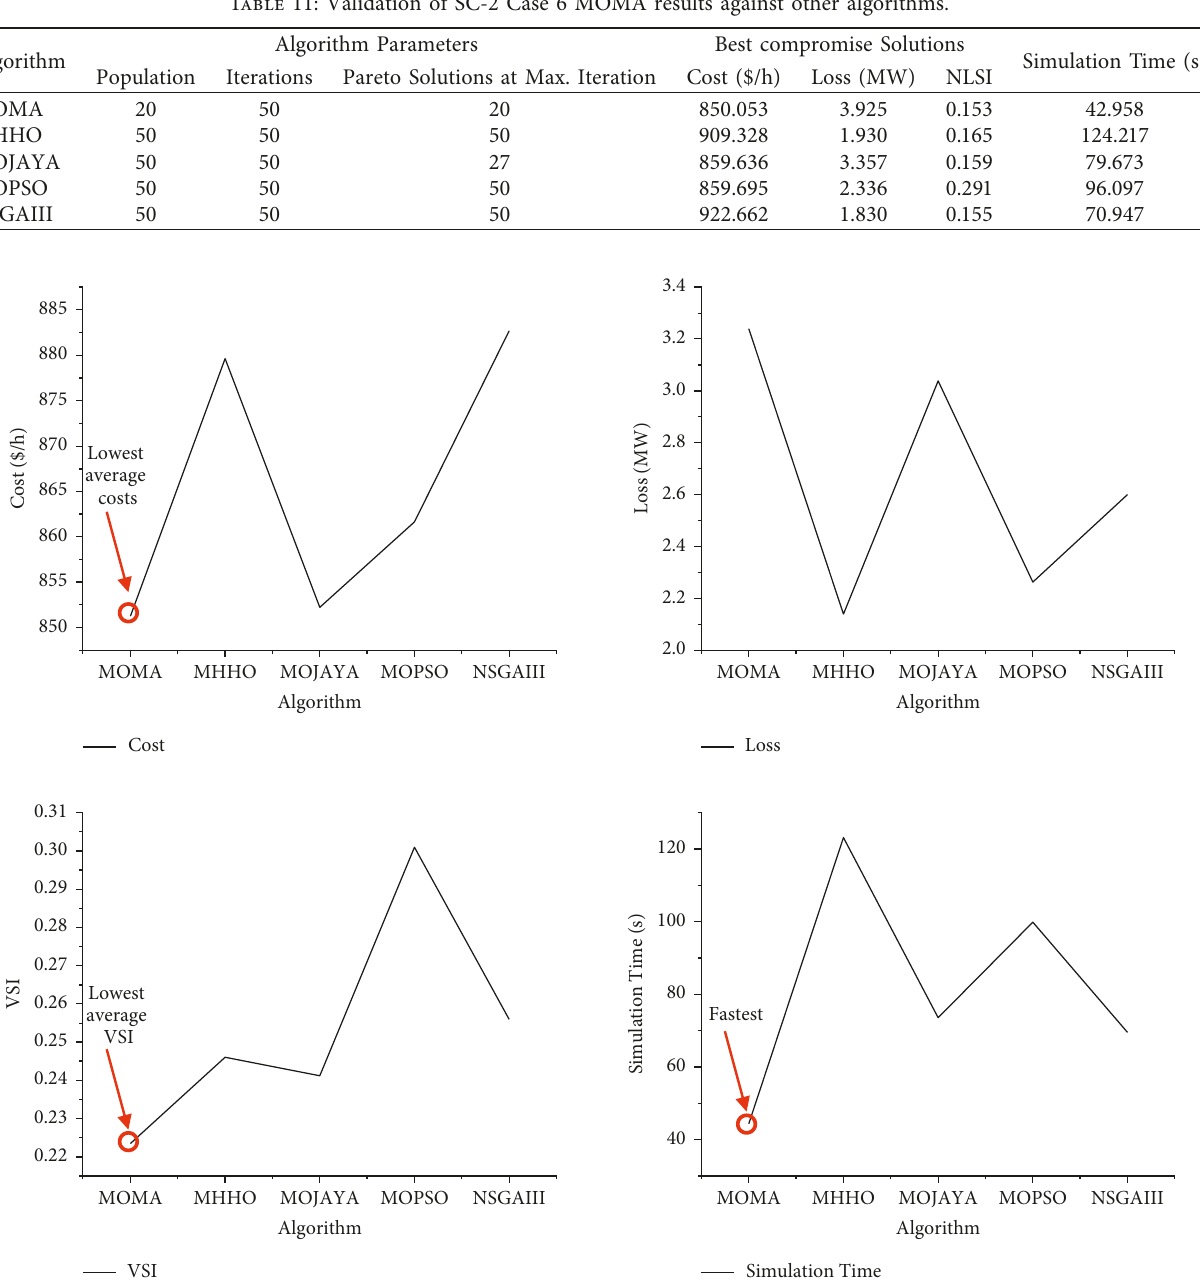
Figure 16: Dominance of MOMA algorithm in average system performance during SC-1 and